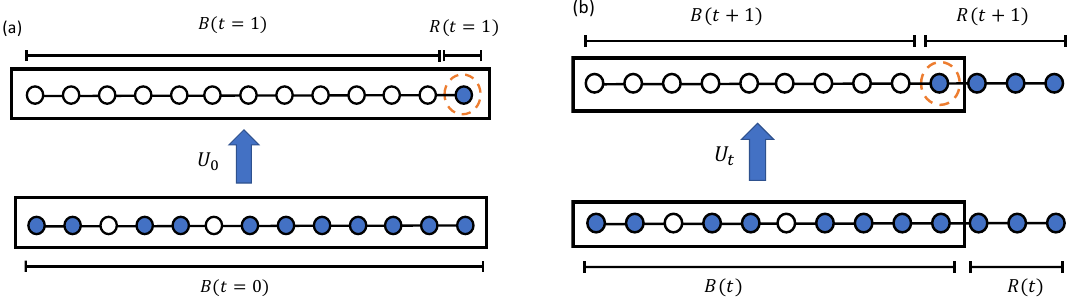
Figure 6 . Macroscopic void formation processes in which operators with non-trivial support some- where in B ( t ) evolve to operators trivial at all sites in B ( t +1) , shown in (a) at t = 0 and in (b) at a later time. Operators have non-trivial support at shaded sites, the region enclosed by the rectangle is the one where the time-evolution operator at time t acts, and the encircled site is the Hawking radiation emitted between times t and t + 1